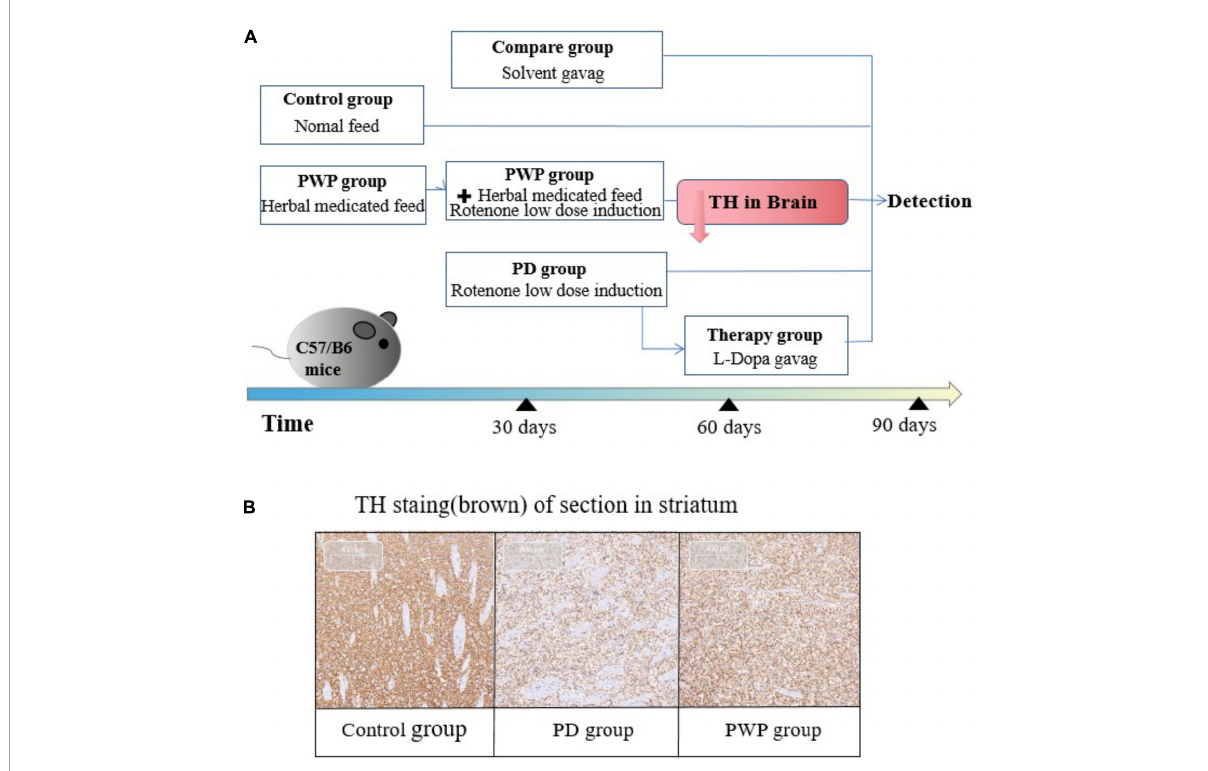
FIGURE1 Experimental process. (A) Mouse experiment study design. (B) Confirmation of PD animal model establishment: TH immunohistochemical staining in striatum on the 60th